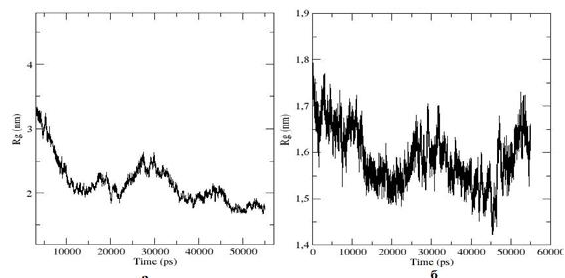
Fig. 2. Time dependence Rg(t) for dendrigraft DG2+16 molecules of KED peptides (a) and for dendrigraft DG2 only